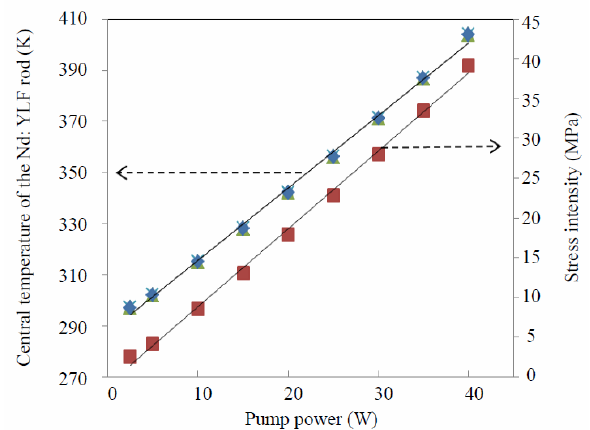
Fig. 3 Calculated maximum temperature and maximum stress intensity in the Nd: YLF laser rod for pump power ranged 2.5 W–40